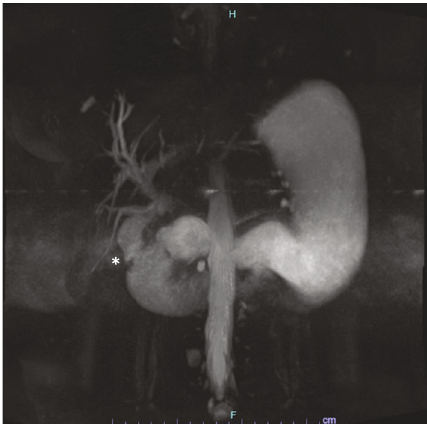
Figure 2: MRCP. Biliary anatomy and the fi stula site (marked by the asterisk). The obstructing gallstone has migrated to the ligament of Treitz at this time.